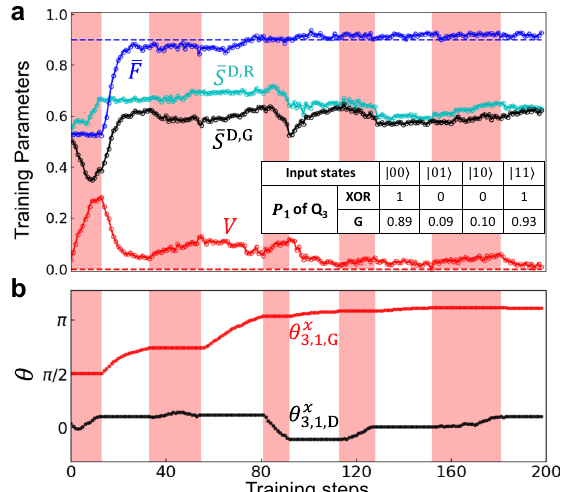
; R = G , and the ; R = G and and 3 ; 1 ; D